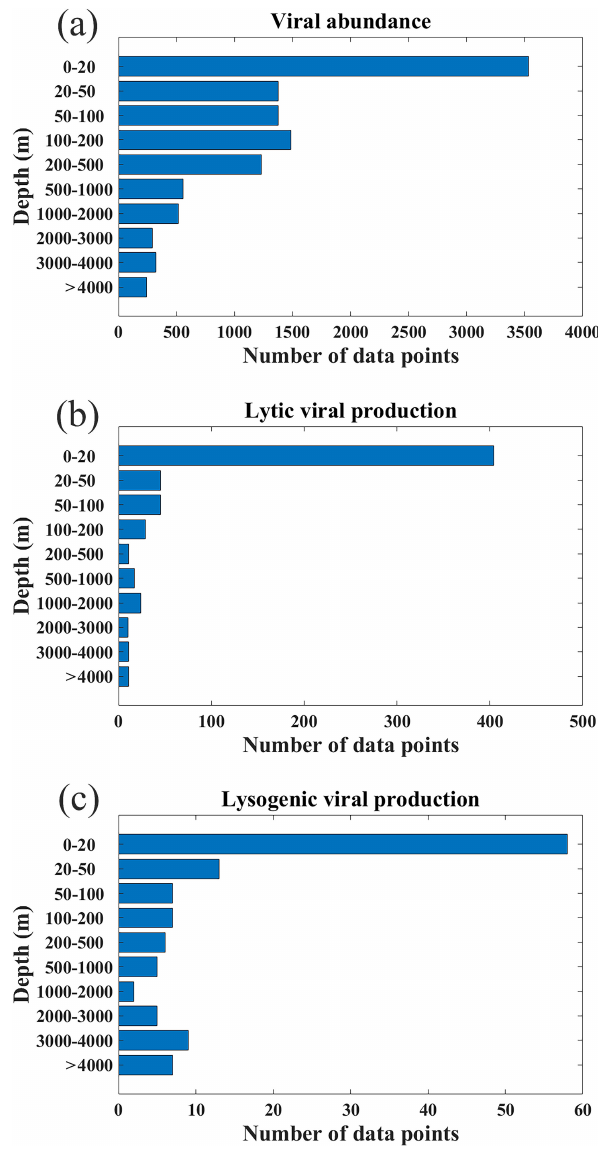
Figure 3. Depth distribution of the data for (a) viral abundance, (b) lytic viral production and (c) lysogenic viral